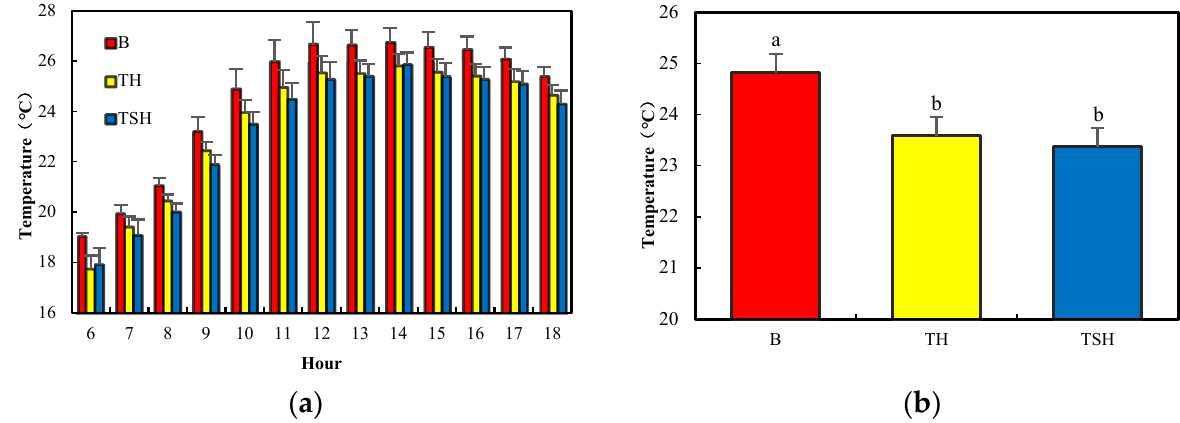
Figure 3. ( a ) Temperature variations for each hour in different vegetation type combinations; ( b ) Average diurnal temperature in different vegetation type combinations. (a,b): the different letters indicate that there is a significant difference between two vegetation type combinations ( p < 0.05).